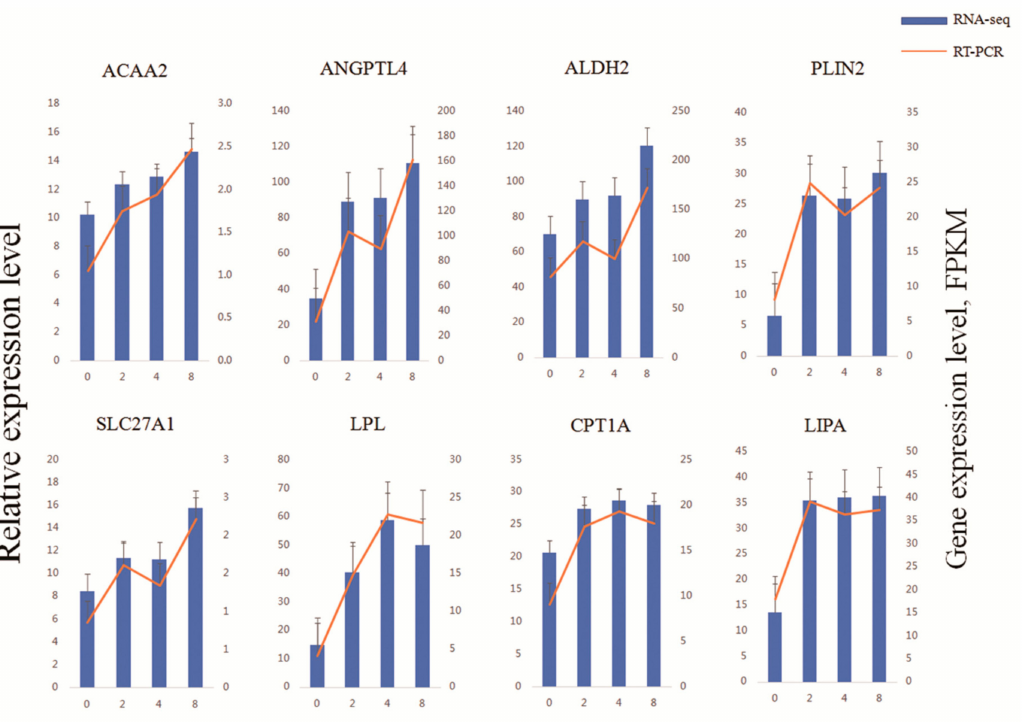
Figure 5. Validation of genes involved in lipid metabolism using reverse transcription (RT)-qPCR.